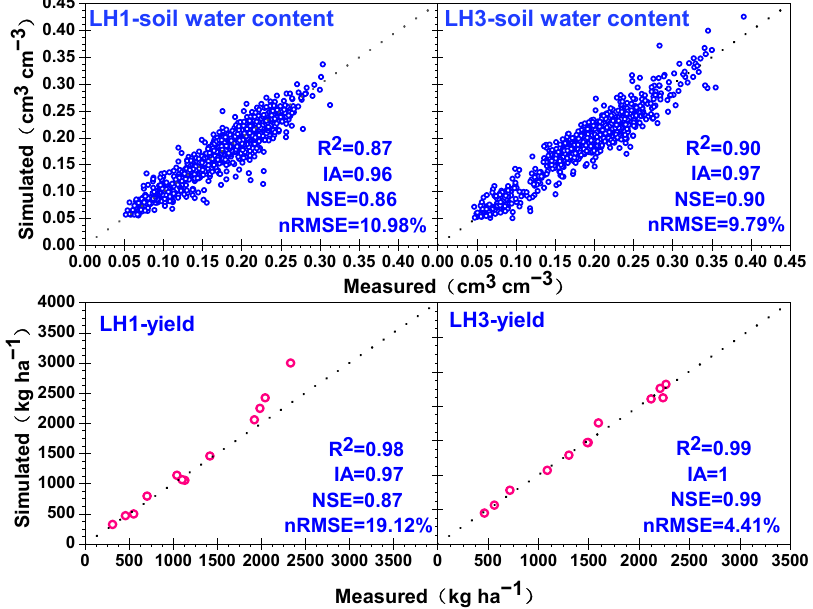
Figure 4. Comparison of measured and simulated values of soil moisture and LH1 and LH3 production under different irrigation schedules in 2017, 2018 and 2020.